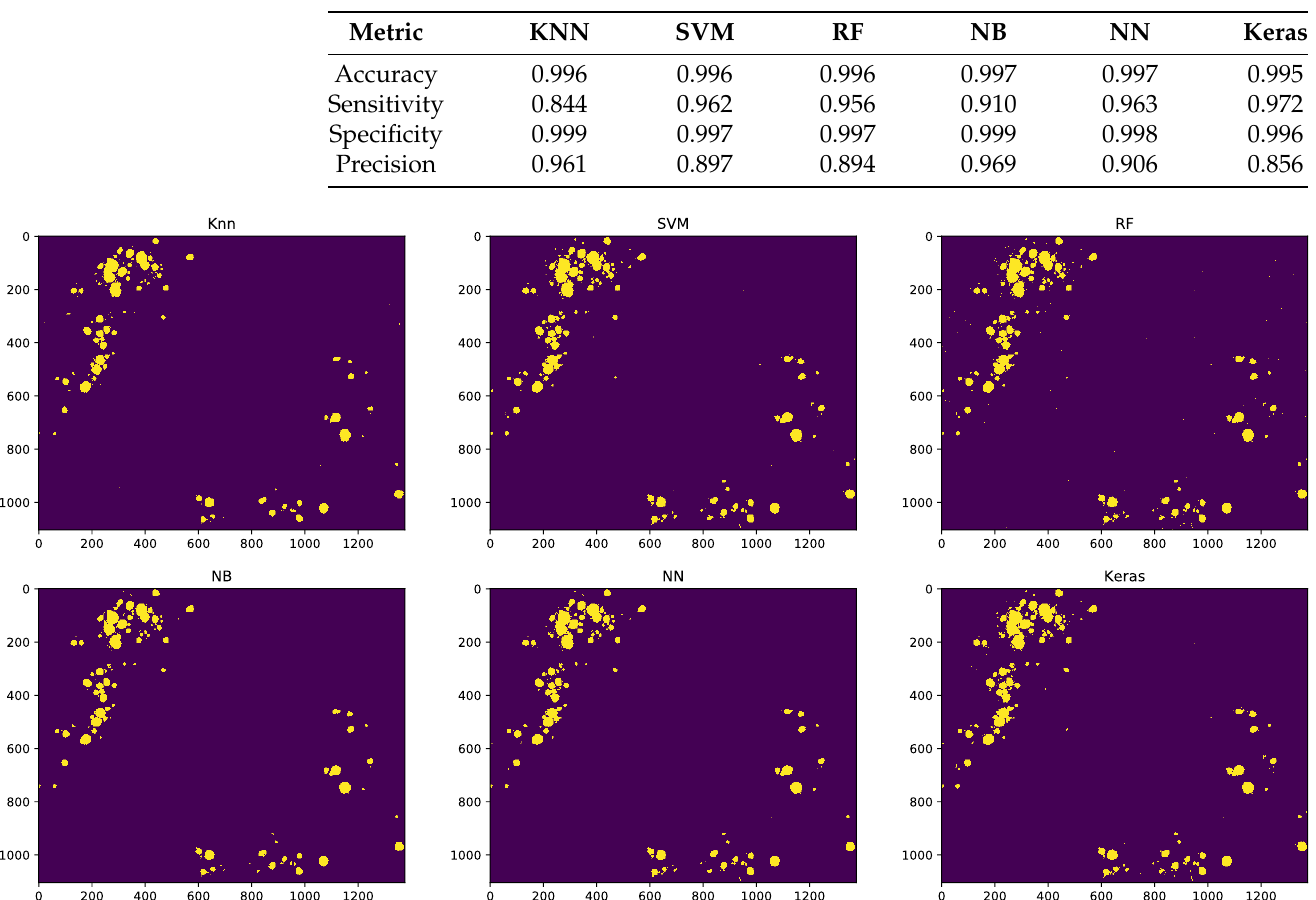
Figure 4. Results of image classification for each